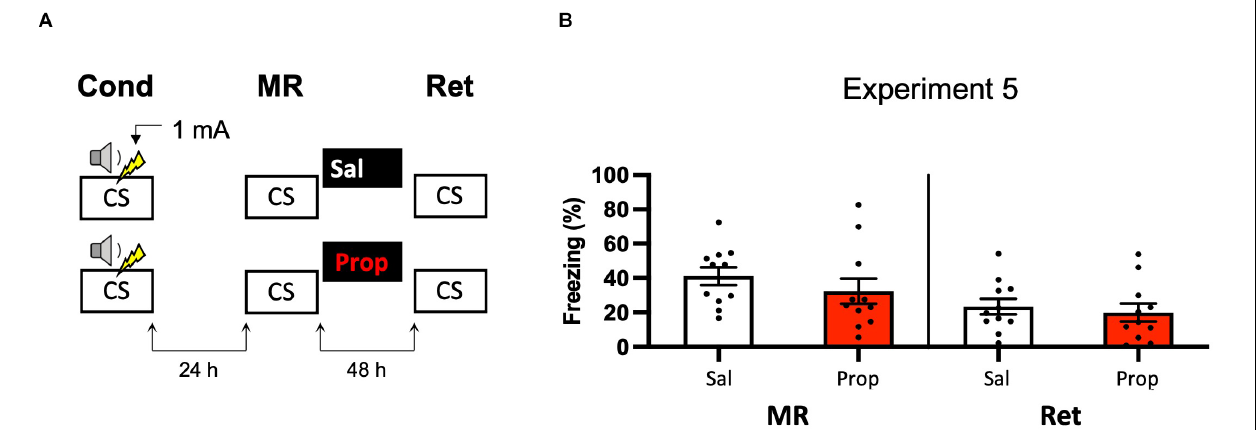
FIGURE 5 | No effect of propranolol on reactivated memories in a background contextual fear-conditioning paradigm. (A) Design of Experiment 5. Mice received one 1 mA shock during presentation of a tone. One day later, mice received saline ( n = 11) or propranolol ( n = 11) after contextual memory reactivation. Forty-eight hours afterward, retention of contextual fear was assessed by exposure to the context. Cond, conditioning; MR, memory reactivation; Ret, retention; CS, conditioned stimulus (context); Sal, saline; Prop, propranolol. (B) Results of Experiment 5. Average percentage of freezing during memory reactivation is displayed on the left panel of the column chart, and freezing during the retention test on the right panel of the column chart (saline in white bars, propranolol in red bars). Error bars represent SEM. Filled circles indicate individual animals.